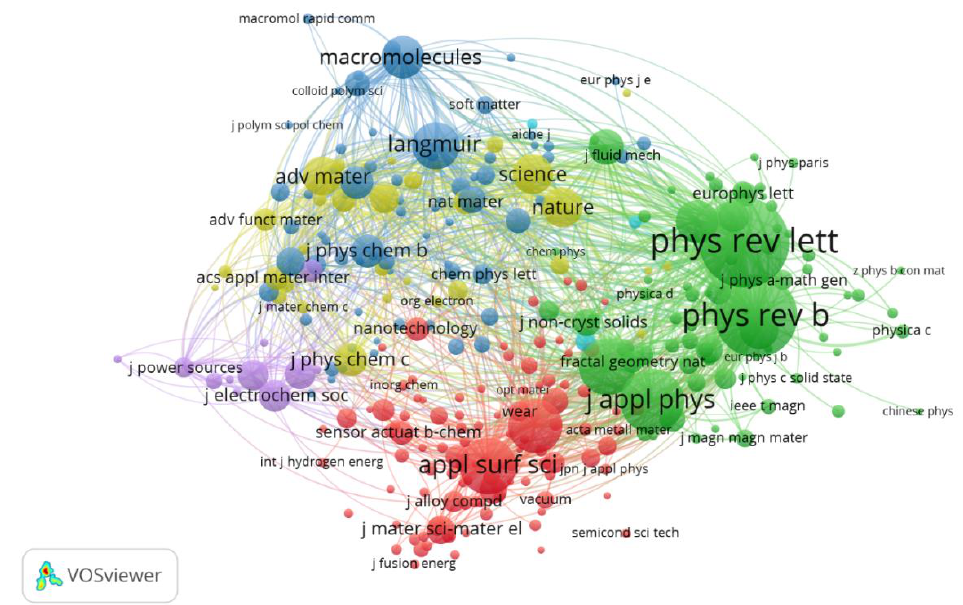
Figure 4. Co-citation of articles across the leading journals in fractal theory of thin films.